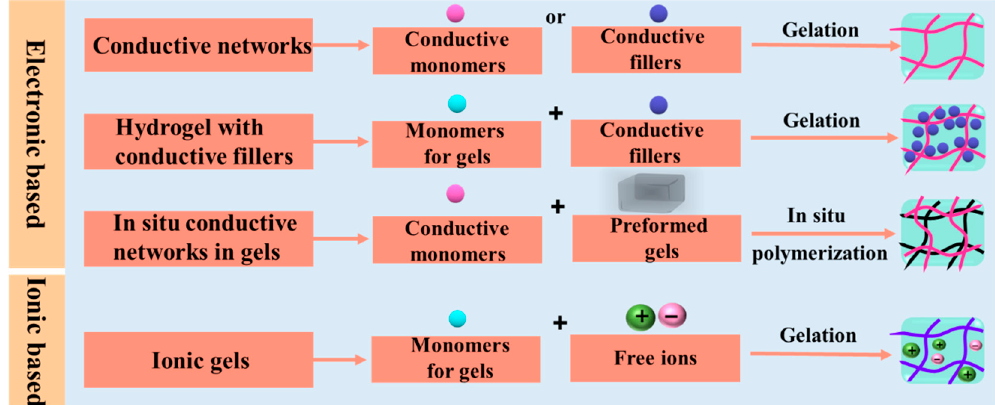
Figure 3. Scheme of preparation methods of conductive hydrogels. Copyright from Ref. [68] Royal Society of Chemistry.